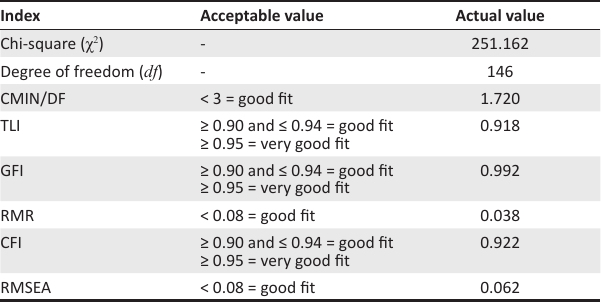
TABLE 5 : Fit indices of the measurement model.